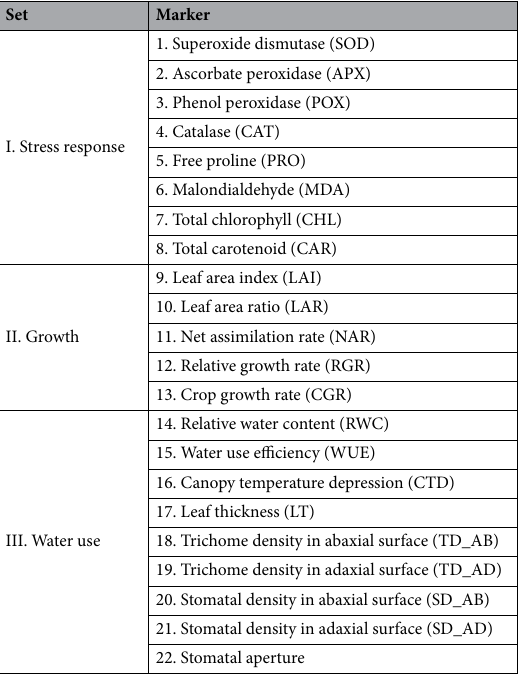
Table 6. Markers evaluated in MUNASQA and TJ2049, clustered by biological processes